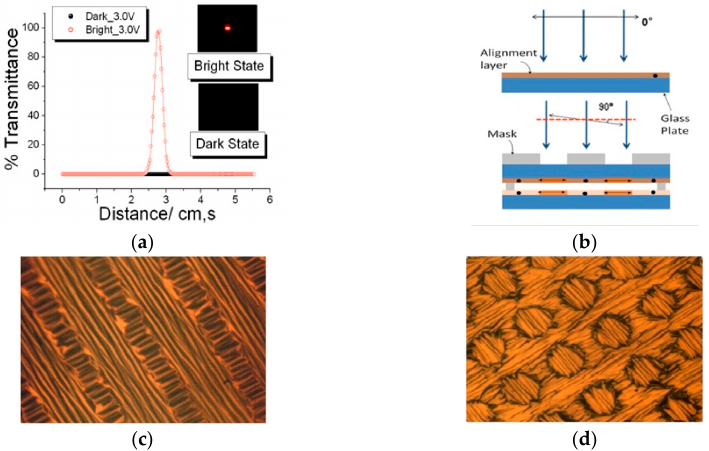
Figure 23. ( a ) The intensity profile of the diffraction of ESH cell between crossed polarizers in bright